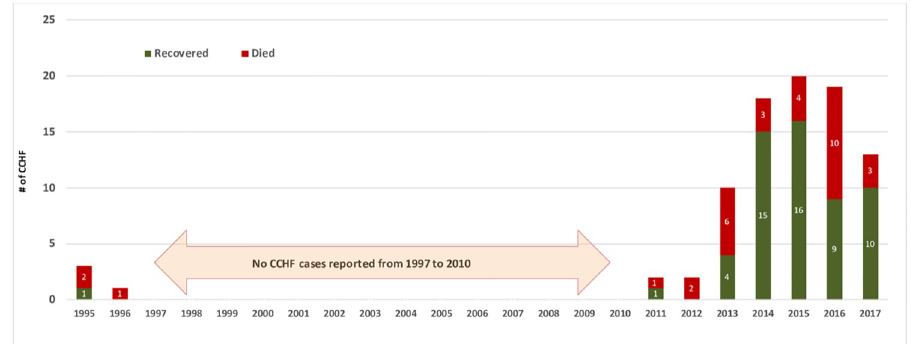
Fig 1. Yearly distribution of CCHF cases and deaths reported in Oman: